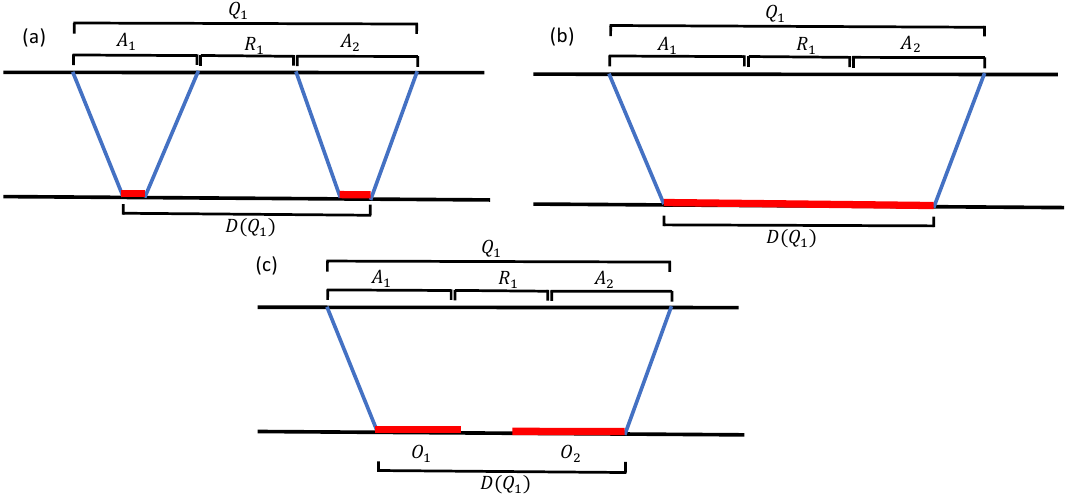
Figure 29 . Possible contributions to N ( A 1 A 2 , D ( Q 1 ); t ) of figure 28. In the figure, red shaded regions have non-trivial operators at all sites, while the unshaded part of the initial operator is